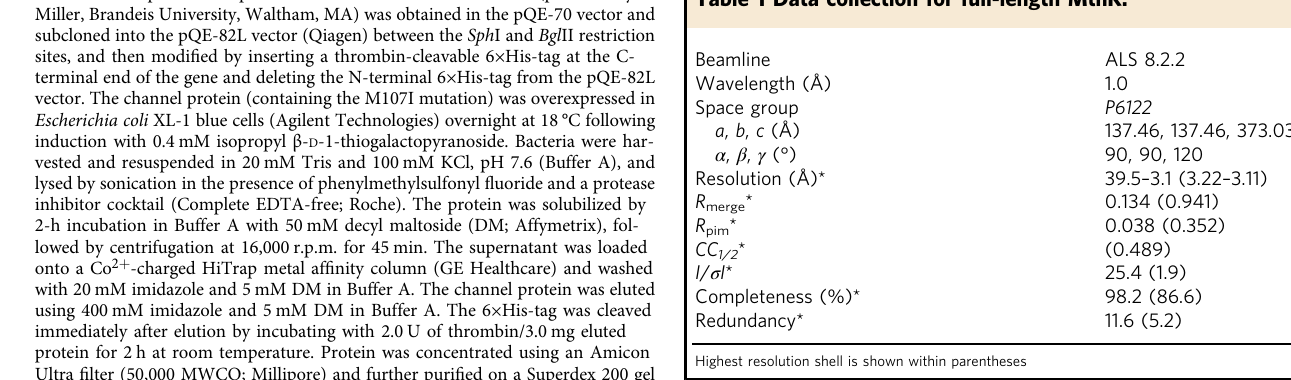
Table 1 Data collection for full-length